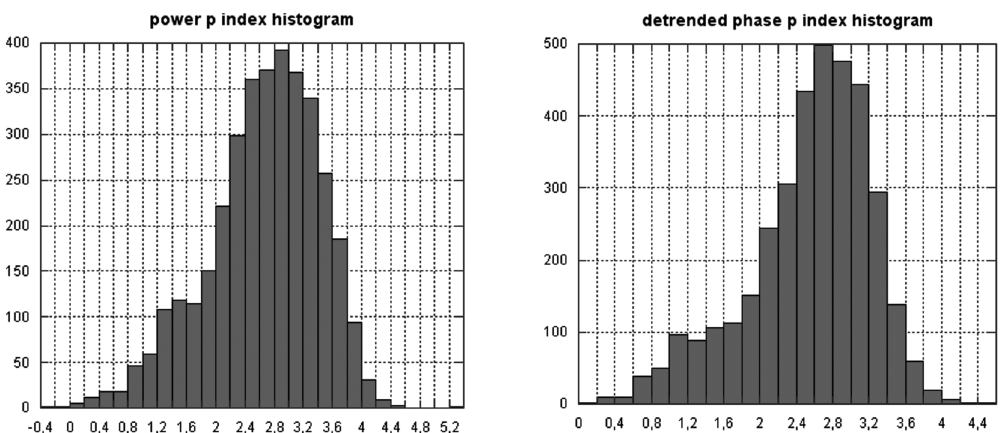
Fig. 5. Histograms of intensity and phase spectrum